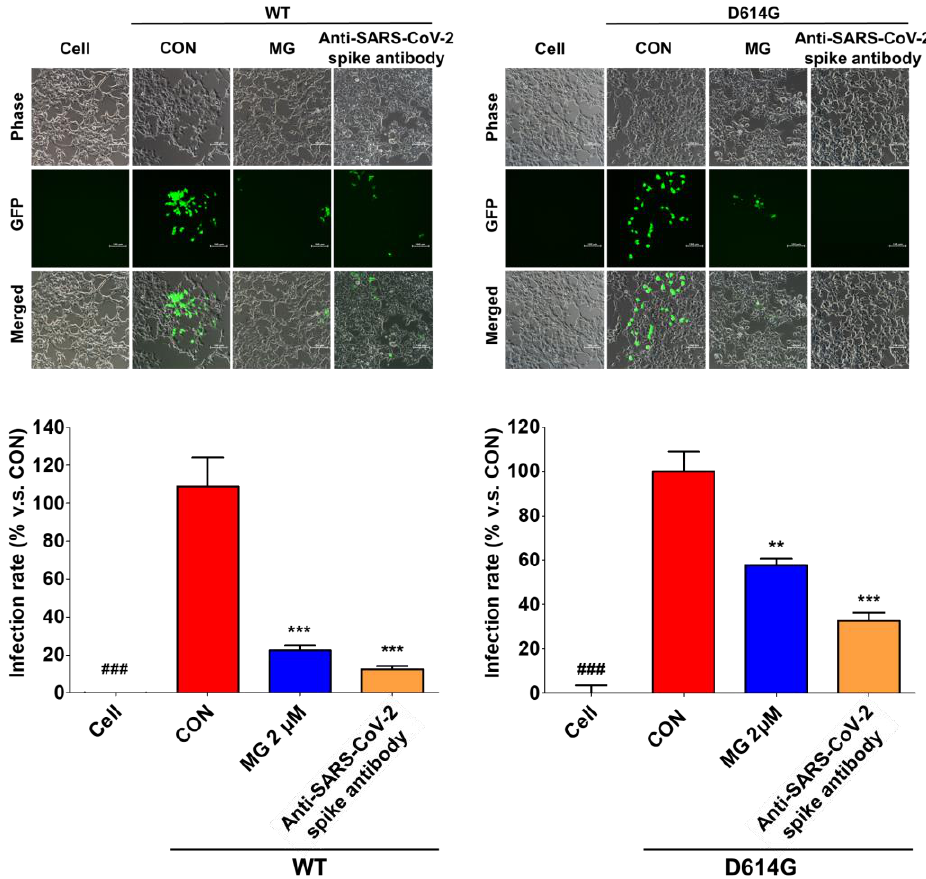
Figure 5. Mulberrofuran G (MG) inhibits SARS-CoV-2 lentiviral pseudovirus infection in HEK293T cells stably expressing human ACE2 and TMPRSS2 cells. HEK293T cells were cultured in 96-well plates (5 × 10 4 cells/well) for 18 h. Next, wild-type (WT) or mutant (D614G) SARS-CoV-2 spike pseu- dovirus (at a final concentration of 1 × 10 4 TU/mL to each well) was incubated with MG (2 μM) or anti-SARS-CoV-2 spike antibody, and the mixtures were incubated at 37 °C for 1 h and then added to HEK293T cells. Green fluorescent protein (GFP) expression levels using flow cytometry were as- sessed at 72 h after viral infection. The inhibitory effect on SARS-CoV-2 spike pseudovirus infection was determined by measuring GFP expression using flow cytometry under a fluorescence micro- scope. Bar graph (mean ± SEM) statistics were determined by three experimental datasets using one- way ANOVA with Tukey’s posthoc test, *** p < 0.001; ** p < 0.01, compared with the control (CON, no MG treatment) samples; ### p < 0.001, compared with the cell-only sample. 3.5. MG Inhibits the Infection of a Clinical Isolate SARS-CoV-2 in Vero Cells We further evaluated the antiviral efficacy of MG against SARS-CoV-2 isolate ( β CoV/Korea/KCDC03/2020) in Vero cells (ATCC-CCL81) and African green monkey kid- ney epithelial cells expressing a high level of the ACE2 receptor. Cells were infected with 0.0125 MOI of SARS-CoV-2 in the presence of MG at various doses. The inhibitory effect of MG on SARS-CoV-2 infection was determined by Hoechst staining and immunofluo- rescence assay using SARS-CoV-2 nucleocapsid protein antibody and Alexa Fluor 488- conjugated IgG. SARS-CoV-2 infection was significantly inhibited by treatment with MG at conce ntrations over 0.78 μM, whereas no inhibition of SARS -CoV-2 infection was ob- served at concentrations less than 0.78 μM MG. The 50% inhibitory concentration (IC 50 ) of MG for SARS-CoV- 2 infection was 1.55 μM (Figure 6). This showed that MG successfully prevents SARS-CoV-2 infection in a clinical isolate.